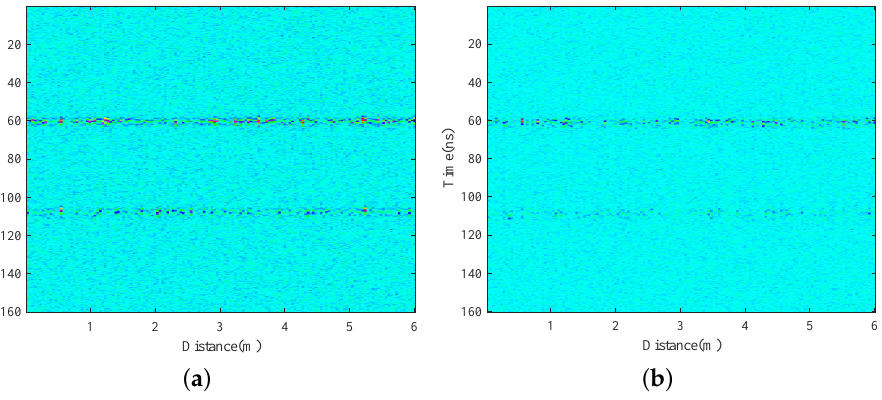
Figure 11. Simulated profiles after adding noise. ( a ) HH polarization mode. ( b ) HV polarization mode.